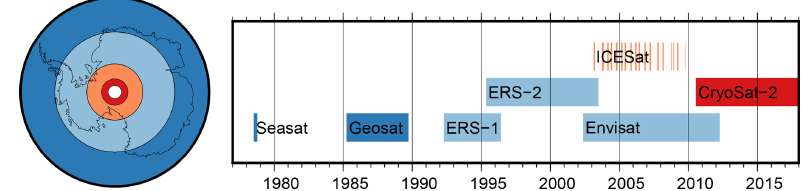
Figure 1. Spatial and temporal coverage of the satellite altimetry data used in this study. The colors denote the maximum southern extent of the measurements (dark blue: 72 ◦ S, light blue: 81.5 ◦ S, orange: 86 ◦ S, red: 88 ◦ S) and thus the size of the respective polar